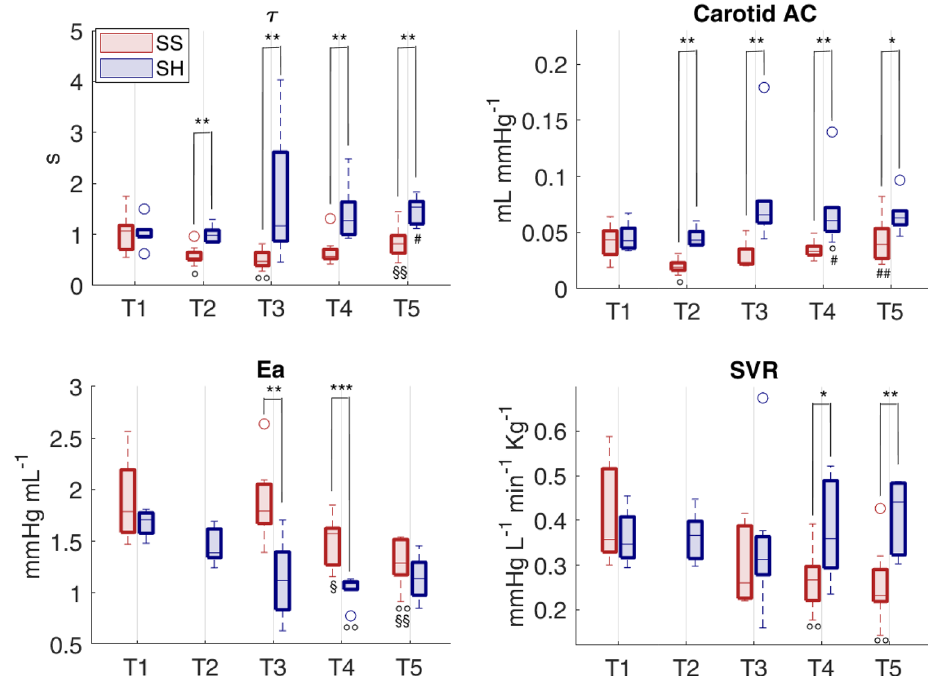
Figure 4. Distributions of values of vascular indices for the two groups at each time point. Comparison between Sepsis and Sham: * p -value < 0.05, ** p -value < 0.01, *** p -value < 0.001 (Wilcoxon rank sum test). Wilcoxon signed test: ° p -value < 0.05, °°p-value < 0.01 with respect to T1, # p -value < 0.05, ## p -value < 0.01 with respect to T2, § p -value < 0.05, §§ p -value < 0.01 with respect to T3 (Friedman test p -value < 0.05).